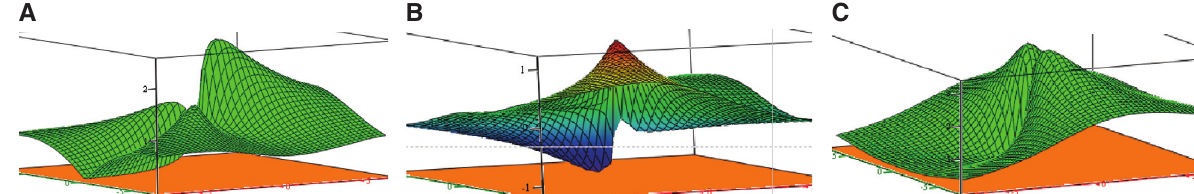
Figure 6 Plots of simplified relations for σ